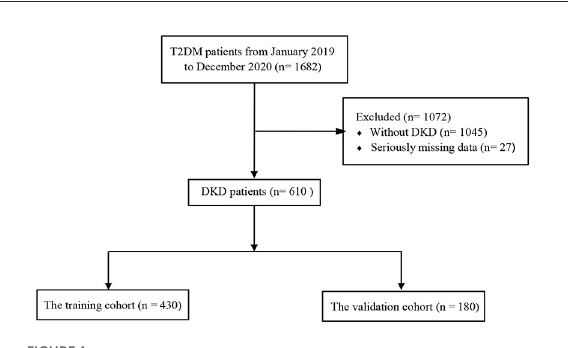
FIGURE1 Flowchart of study participants. T2DM, type 2 diabetes mellitus; DKD, diabetic kidney disease.